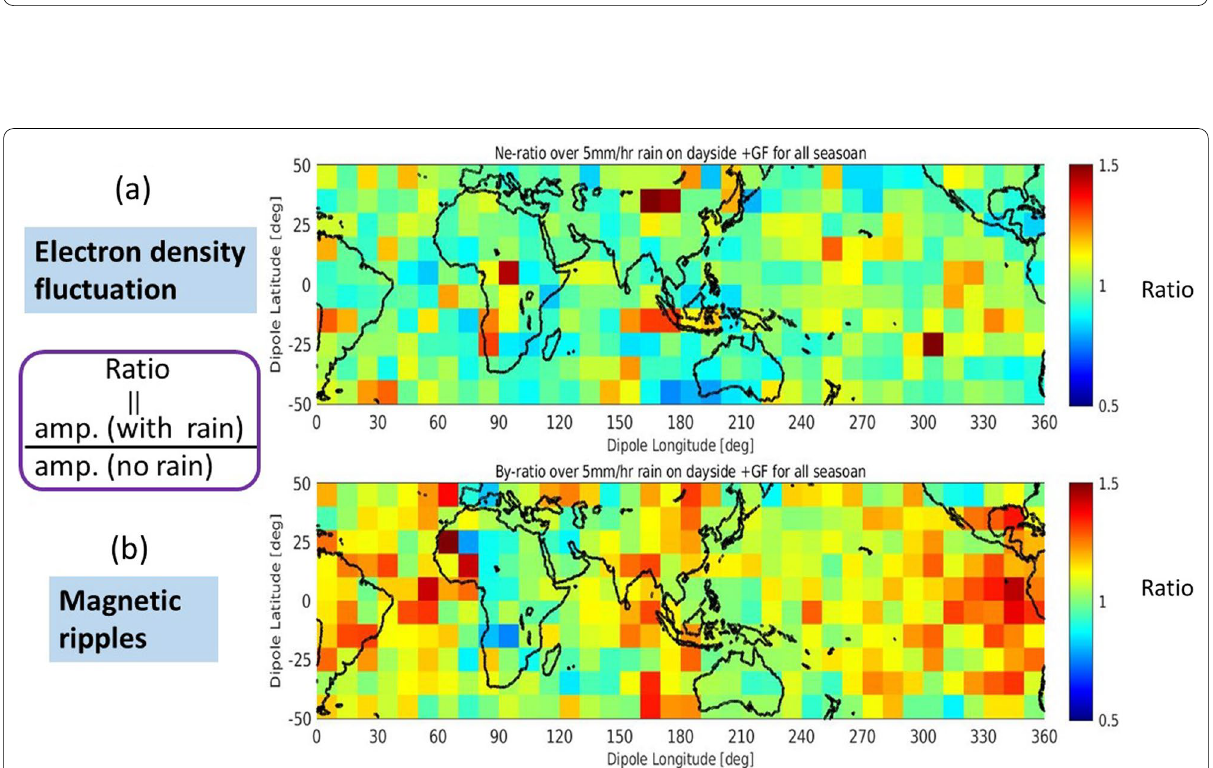
Fig. 5 a Difference of mean rainfall between autumnal equinox (Aug–Oct) and vernal equinox (Feb–Apr), b same as a but of mean electron density fluctuations